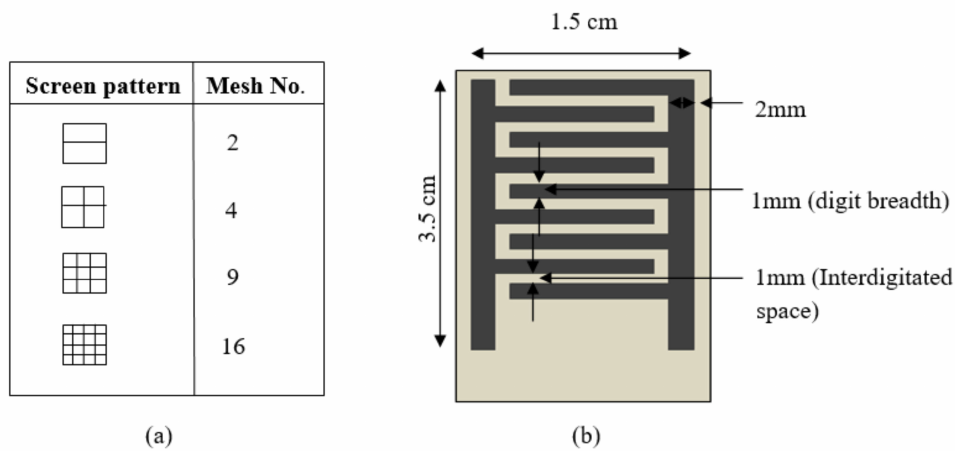
Figure 9. ( a ) Examples of screen pattern corresponding to a given mesh number. ( b ) Illustration of interdigitated pattern with corresponding dimensions of fabricated